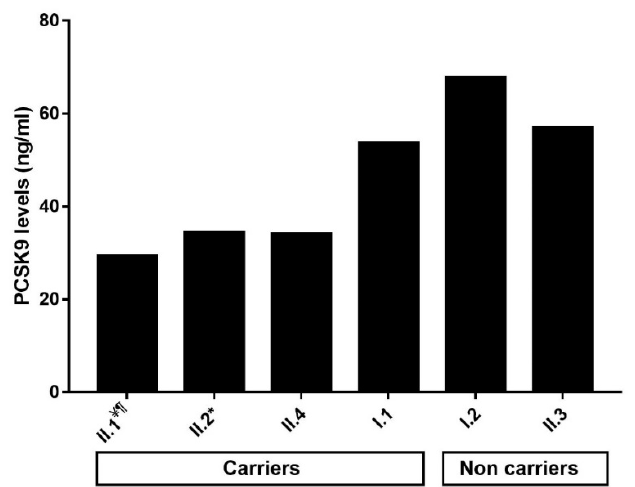
Figure 2. Levels of circulating PCSK9 in the carriers of the p.(Arg490Trp) variant and the non-carriers in family 1. ¥ Indicates the proband in the family. ¶ Indicates that PCSK9 levels were measured in the serum because plasma was not available and that the value was dismissed while calculating the mean and the standard deviation in plasma. * Indicates that the subject was not fasting when the blood sample was collected.